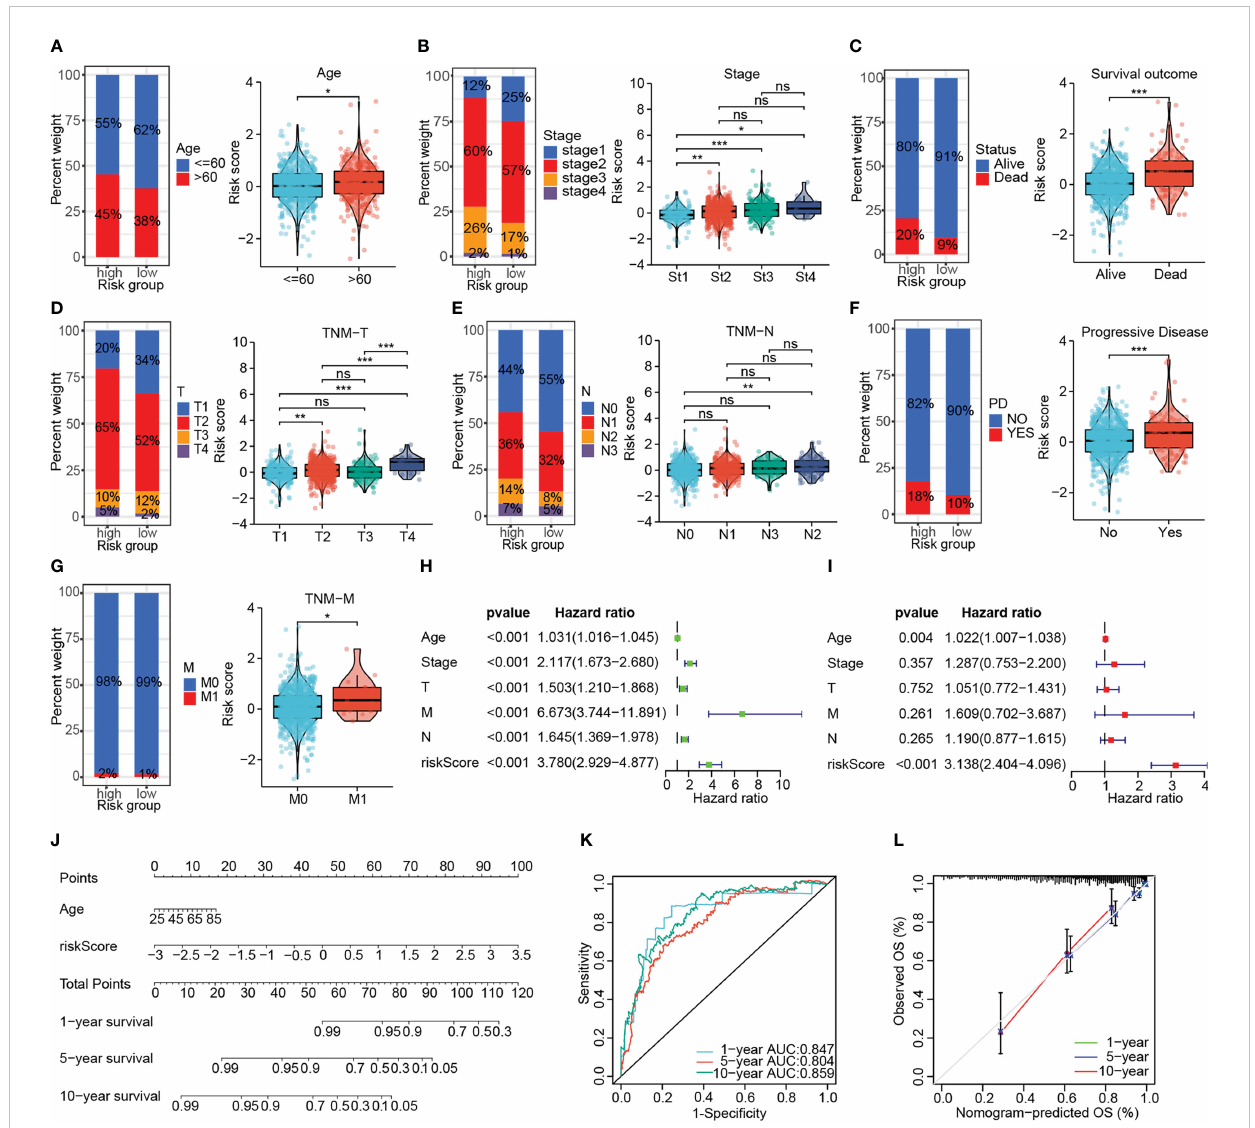
FIGURE 4 Investigating the association of the signature with the clinicopathological characteristics of patients in the TCGA-BRCA cohort. The association of the signature with the age (A) , AJCC stage (B) , survival outcome (C) , AJCC T-stage (D) , AJCC N-stage (E) , disease status (F) and AJCC M-stage (G) . (H, I) Univariate and multivariate Cox analyses con fi rmed the independent prognostic role of the signature. (J) The predictive nomogram containing the risk score and another independent prognostic factor. (K, L) The ROC curve and calibration curve to assess the predictive accuracy of the nomogram. (ns: not signi fi cant, * P < 0.05, ** P < 0.01, *** P <